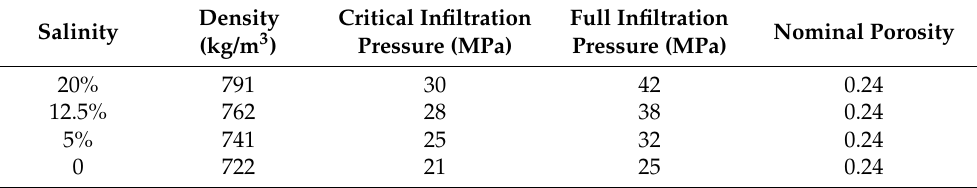
Table 3. Silica aerogel material